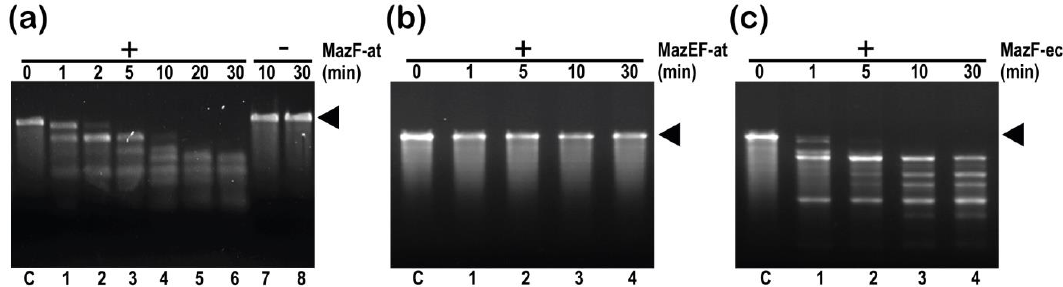
Figure 5. Endoribonuclease activity assay of ( a ) MazF-at, ( b ) MazEF-at complex, and ( c ) MazF-ec on MS2 phage RNA. 0.5 µM of MazF-at, MazEF-at, or MazF-ec protein was incubated with 0.8 µg/µL MS2 phage RNA, and the reaction was loaded on 1.5% agarose gel. The arrowheads indicate the full-length of MS2 phage RNA.